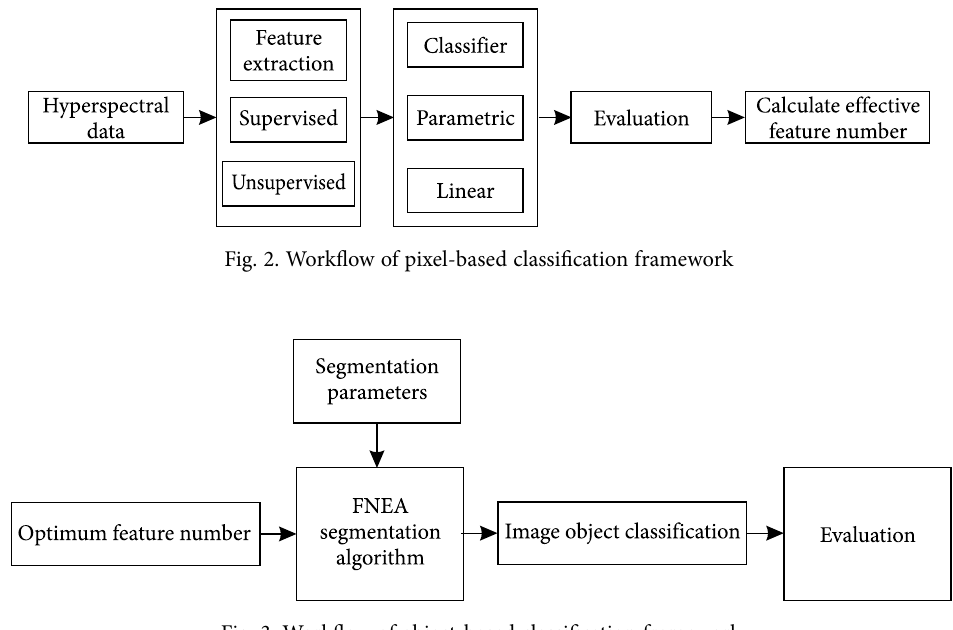
Fig. 3. Workflow of object-based classification